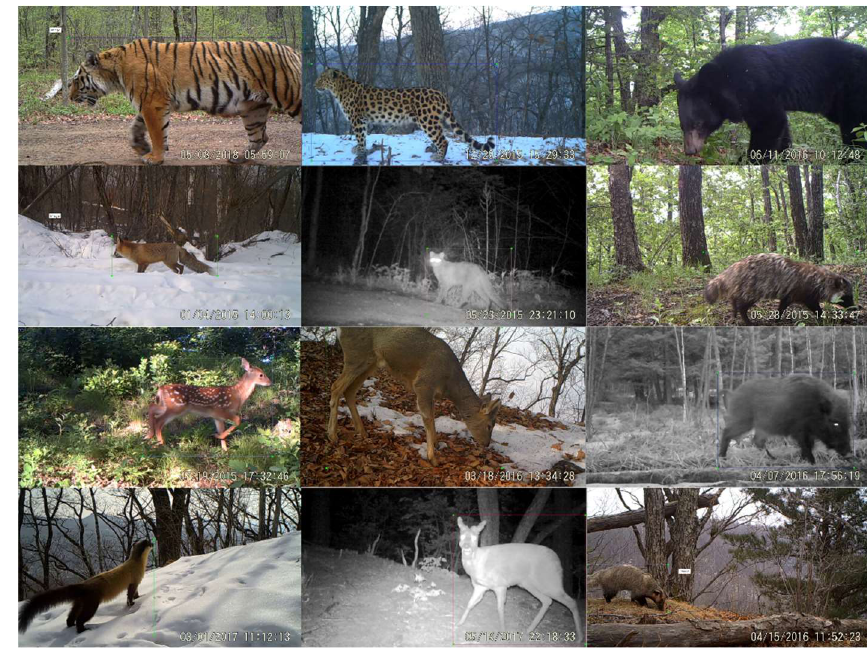
Figure 1. Examples of some species of the NTLNP dataset.